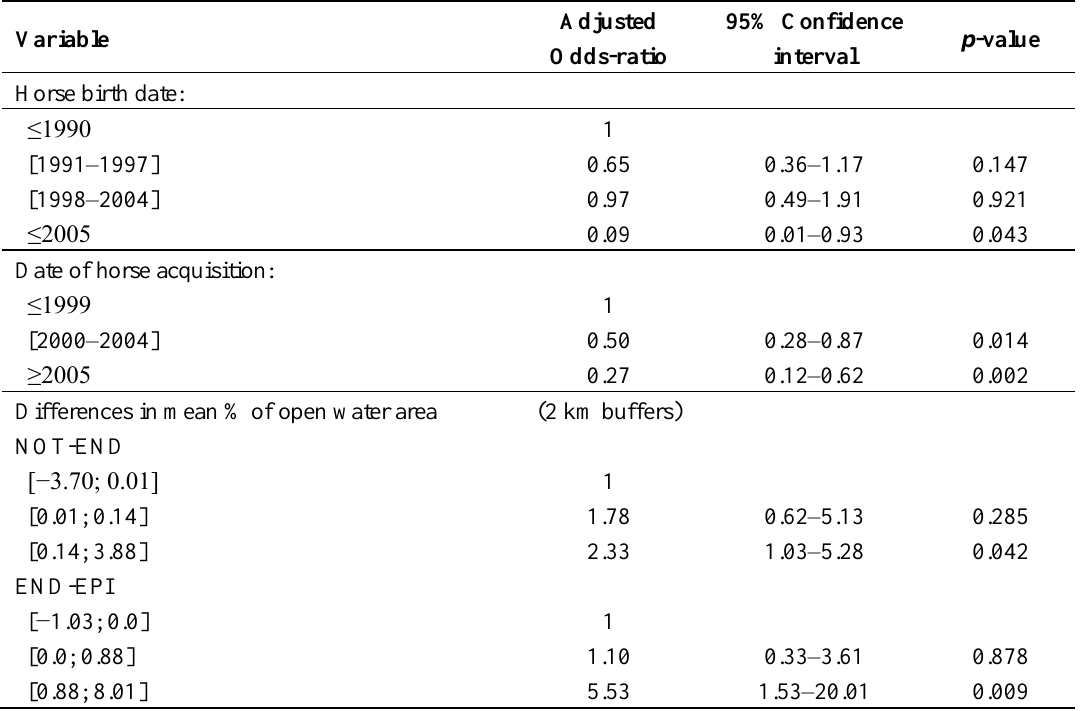
Table 4. Results of the final logistic regression model for the serological status of West Nile virus in equids in Southern France,